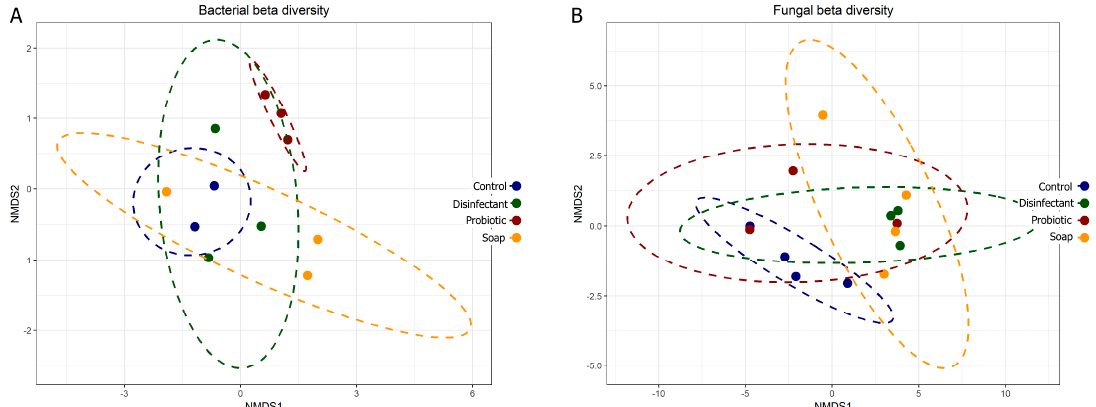
Figure 3. Bacterial ( A ) and fungal ( B ) beta diversity plots comparing community composition impacts of four cleaning regimes on indoor linoleum blocks. Each dot represents one of four swabs per cleaning regime, each plotted separately.